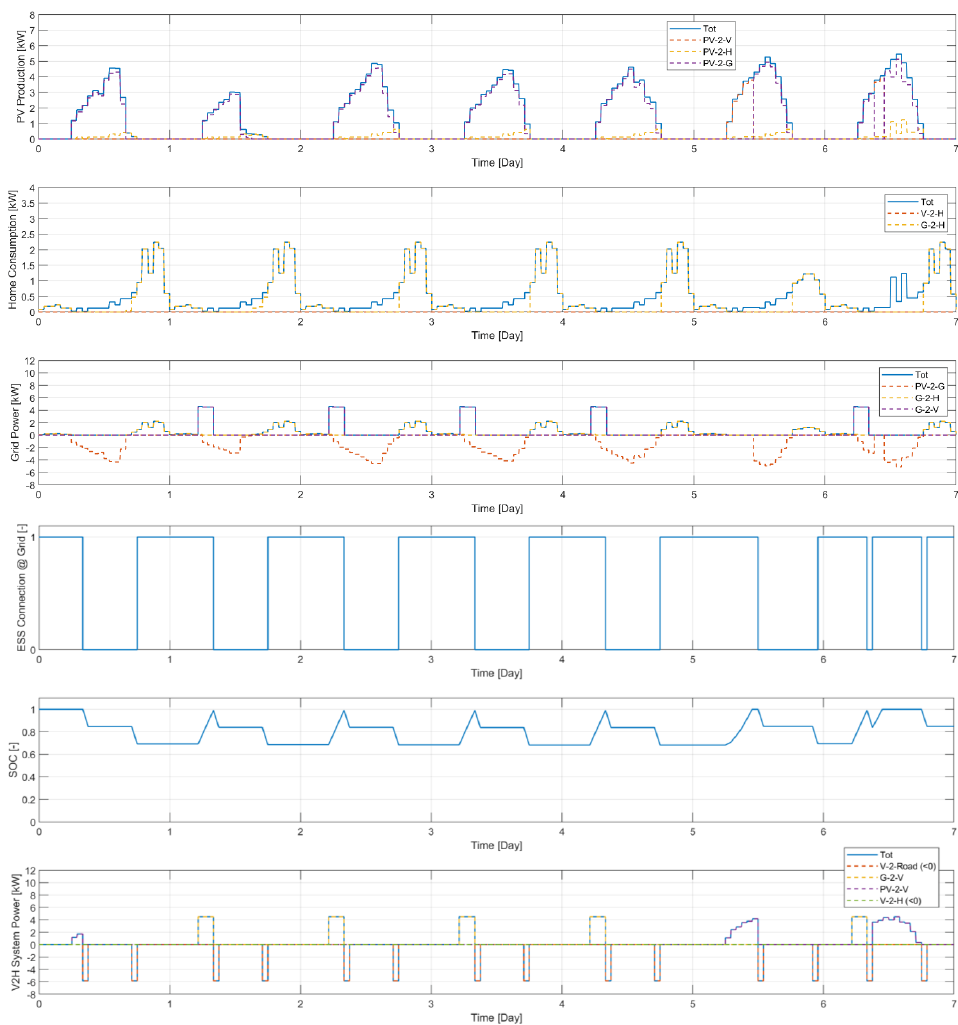
Figure 13. Summer week. Case1A — OW 1D results.